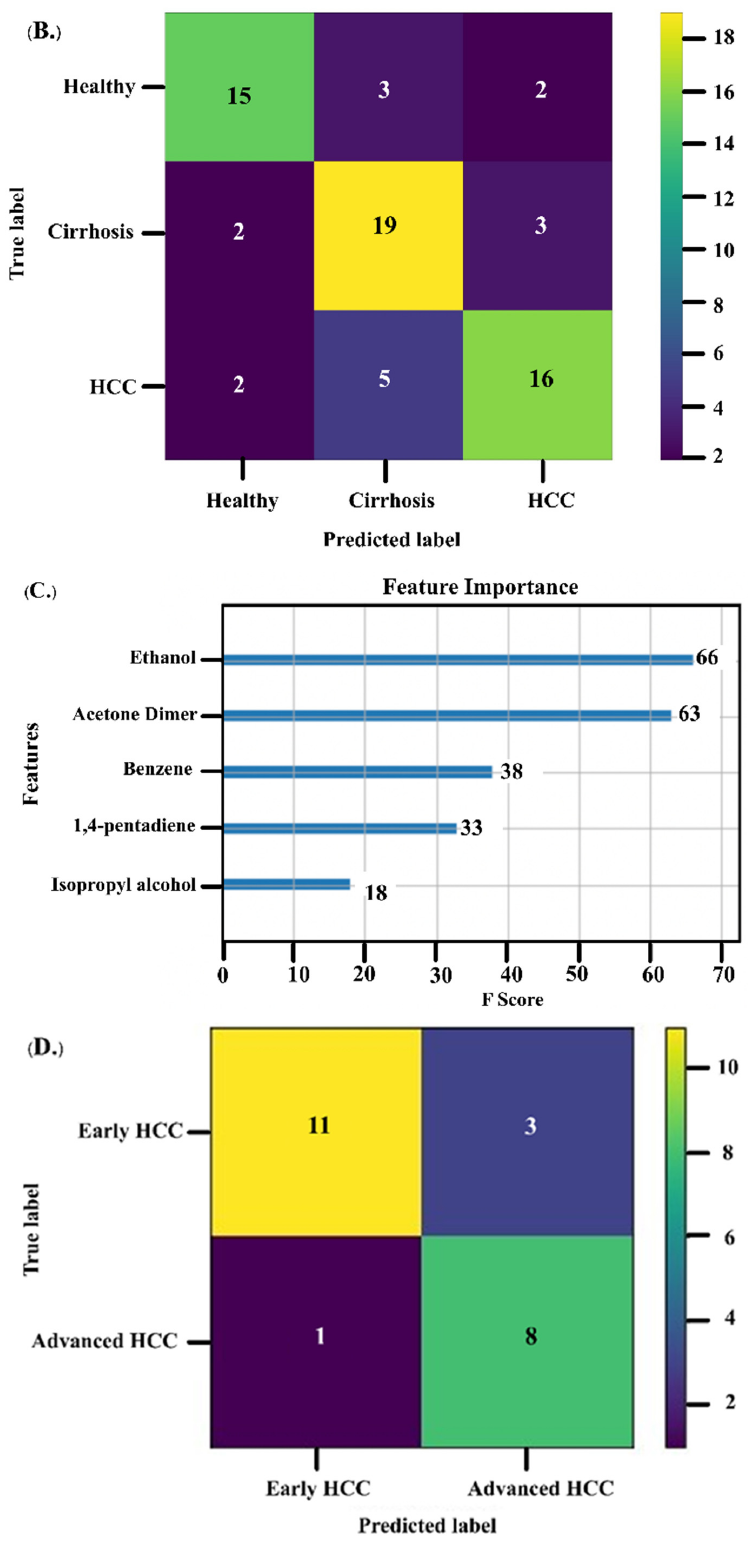
Figure 2. ( A ) A feature importance score (F score) of VOCs used to discriminate among HCC, cirrhosis, and healthy controls, ( B ) The confusion matrix from XGBoost to classify participants as HCC, cirrhosis, and healthy controls, ( C ) F score of VOCs to discriminate between the early (BCLC stages 0-A) and advanced (BCLC stages B-C) HCC stages, ( D ) The confusion matrix from XGBoost to differentiate between early HCC and advanced